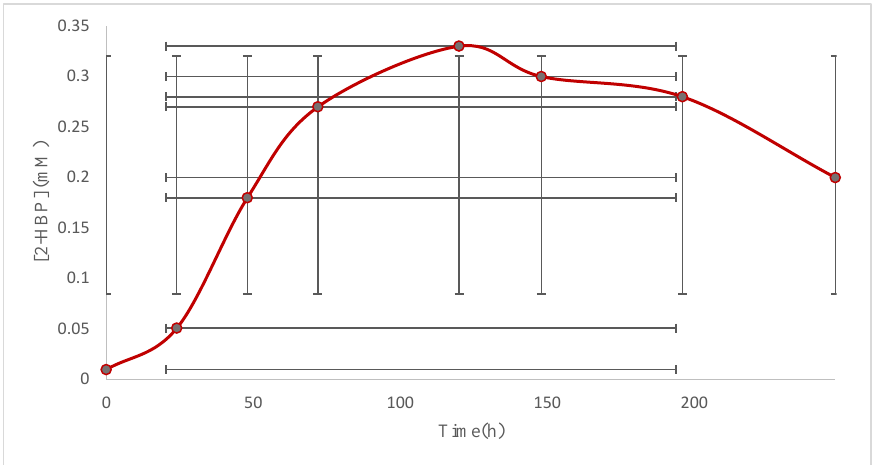
Figure 5. The concentration of produced 2-HBP by the nondecorated cells.